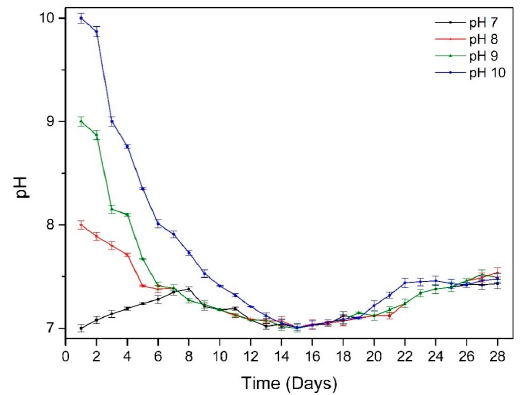
Figure 2. Dissolved sulphide levels over time for samples at different starting pH.